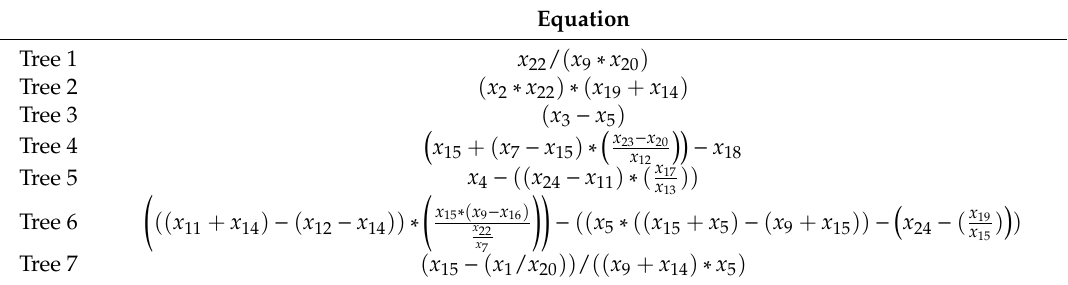
Table 7. Equations of Subtrees of Best Model of ABCP-Descriptor for DS-Kylberg.